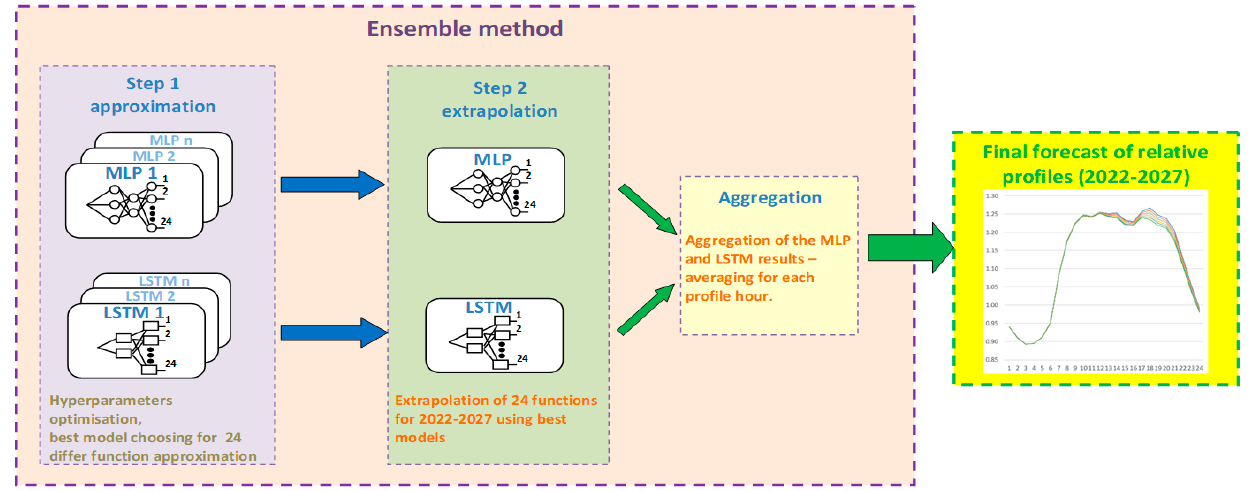
Figure 12. Conceptual graph of the proposed method for relative profile forecasting.